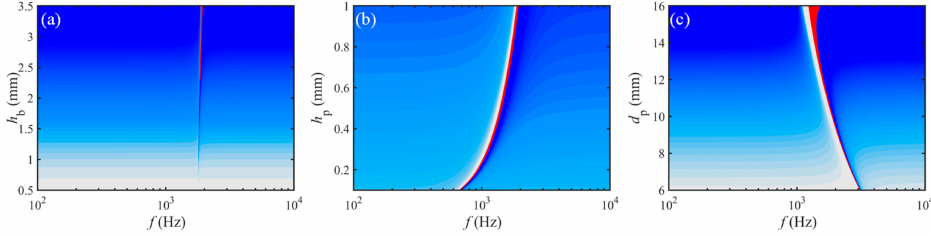
Figure 7. Variation of the equivalent SD with geometric parameters: ( a ) h b , ( b ) h p , and ( c ) d p .